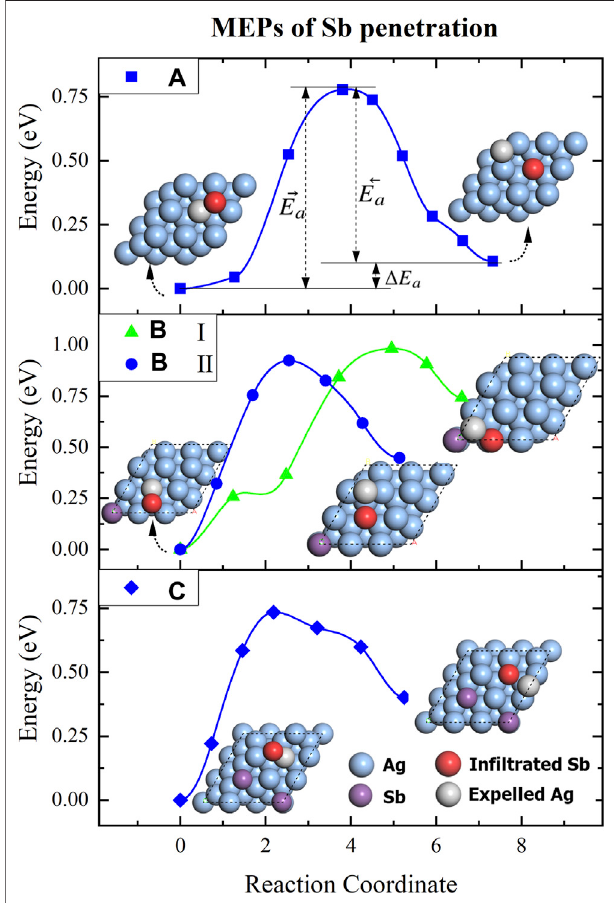
FIGURE 8 | The MEPs of the Sb atoms continuously replace the Ag atoms in surface of Ag(111) substrate. (A) is the fi rst step of one Sb atom penetrating into Ag(111) surface. B (I) and B (II) are the second step of another Sb atom penetrate into the fi nal state of step A at neighbor and sub-neighbor sites, respectively. C is the third step of Sb atom penetrate into the fi nal state of step B (II) at sub-neighbor site. The purple and blue balls representthe Ag and Sb atoms, thered and gray balls represent thein fi ltrated Sb atom and expelled Ag atoms, respectively.